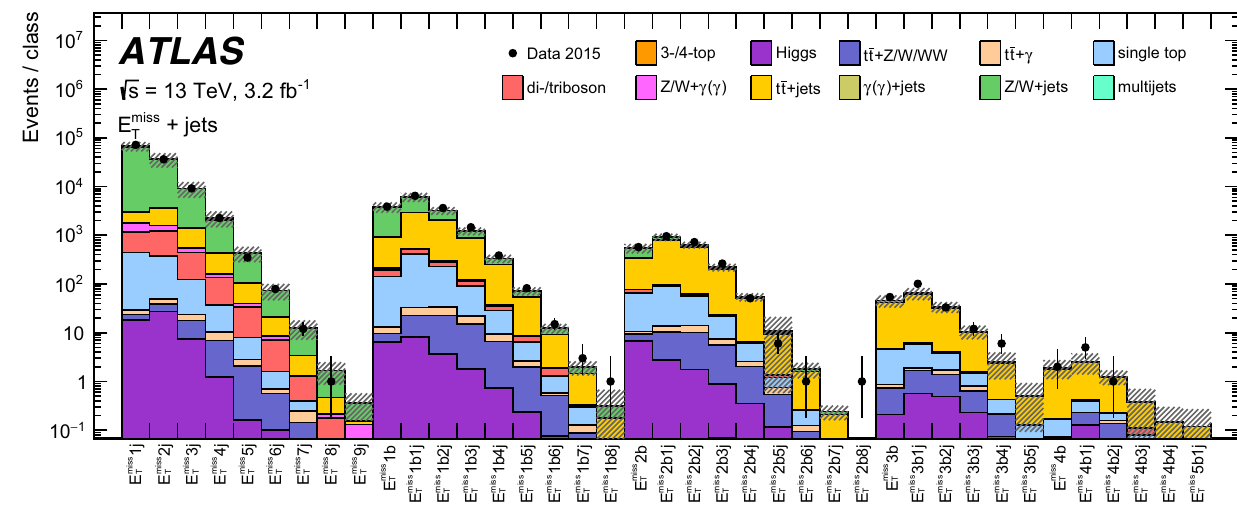
Fig. 19 The number of events in data, and for the different SM back- ground predictions considered, for classes with large E miss (no leptons or photons). The classes are labelled according to the mul-